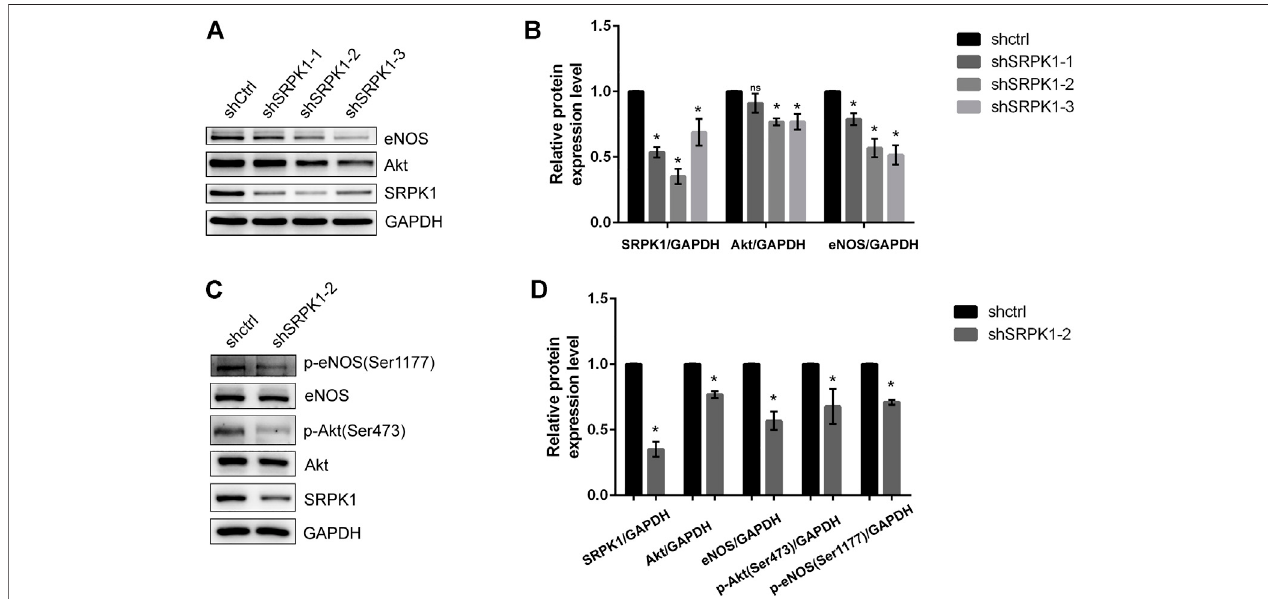
FIGURE 4 | SRPK1 knockdown decreases the expression and phosphorylation of eNOS. HUVECs were transfected with lentiviral shRNA speci fi c for 3 independent sequences of SRPK1 (shSRPK1-1, shSRPK1-2, and shSRPK1-3) and a scrambled shRNA (shCtrl). The levels of the eNOS, Akt and SRPK1 were determined by western blot (A) with the quanti fi cations of the related proteins (B) . Followed by the transfection with lentiviral shSRPK1-2, the levels of the eNOS, phosphor-eNOS (Ser1177), Akt, phosphor-Akt (Ser473), and SRPK1 were determined by western blot (C) with the quanti fi cations of the related proteins (D) . The dataarepresentedasthemean±SDofthreeindependentexperiments.One-wayANOVAwithaleastsigni fi cantdifferenceposthoctestfor B andStudent ’ st-testfor D were used. ns, p > 0.05; *, p < 0.05 vs